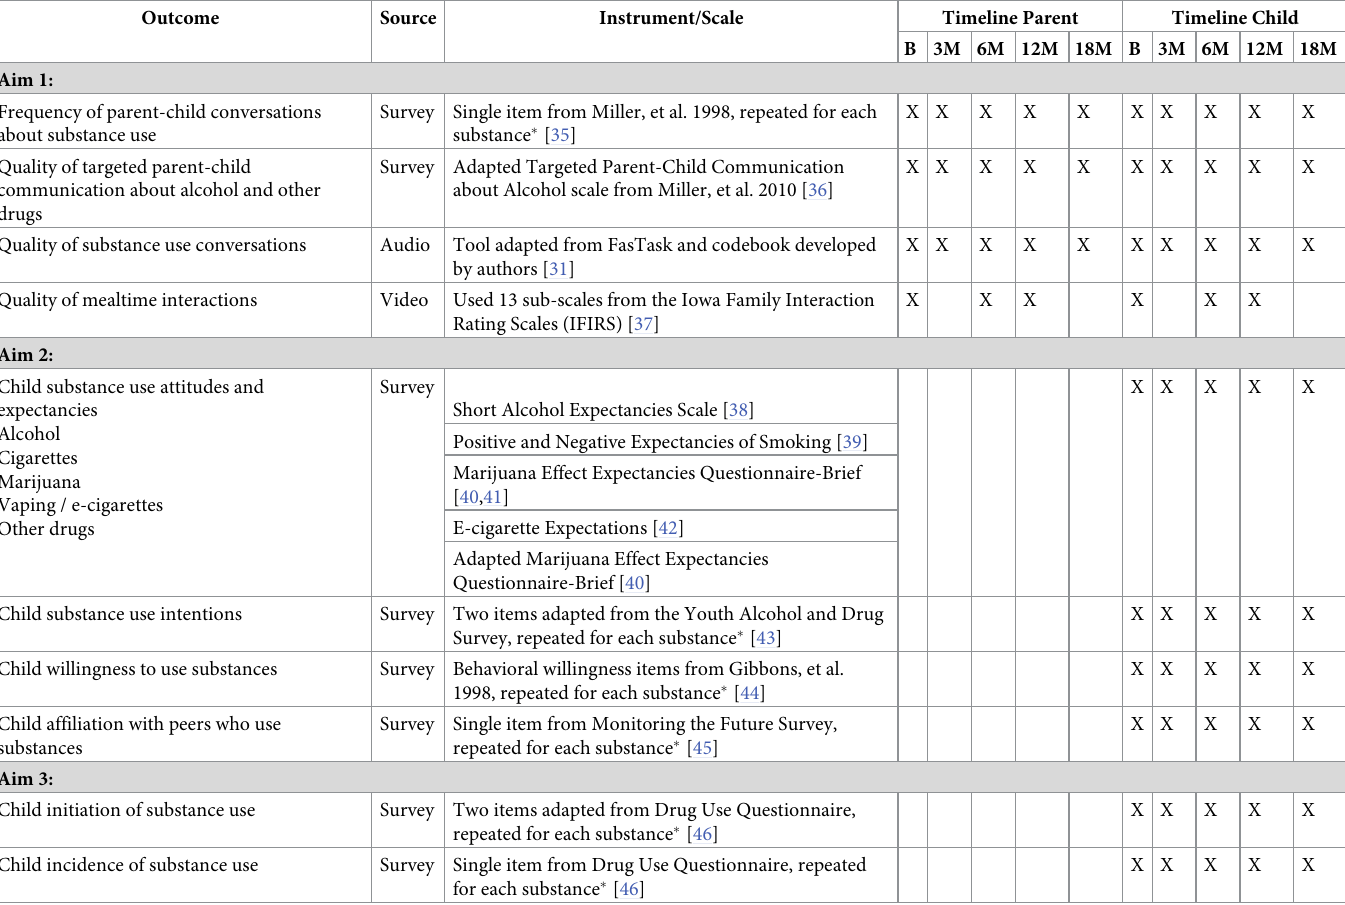
Table 1. Study measures